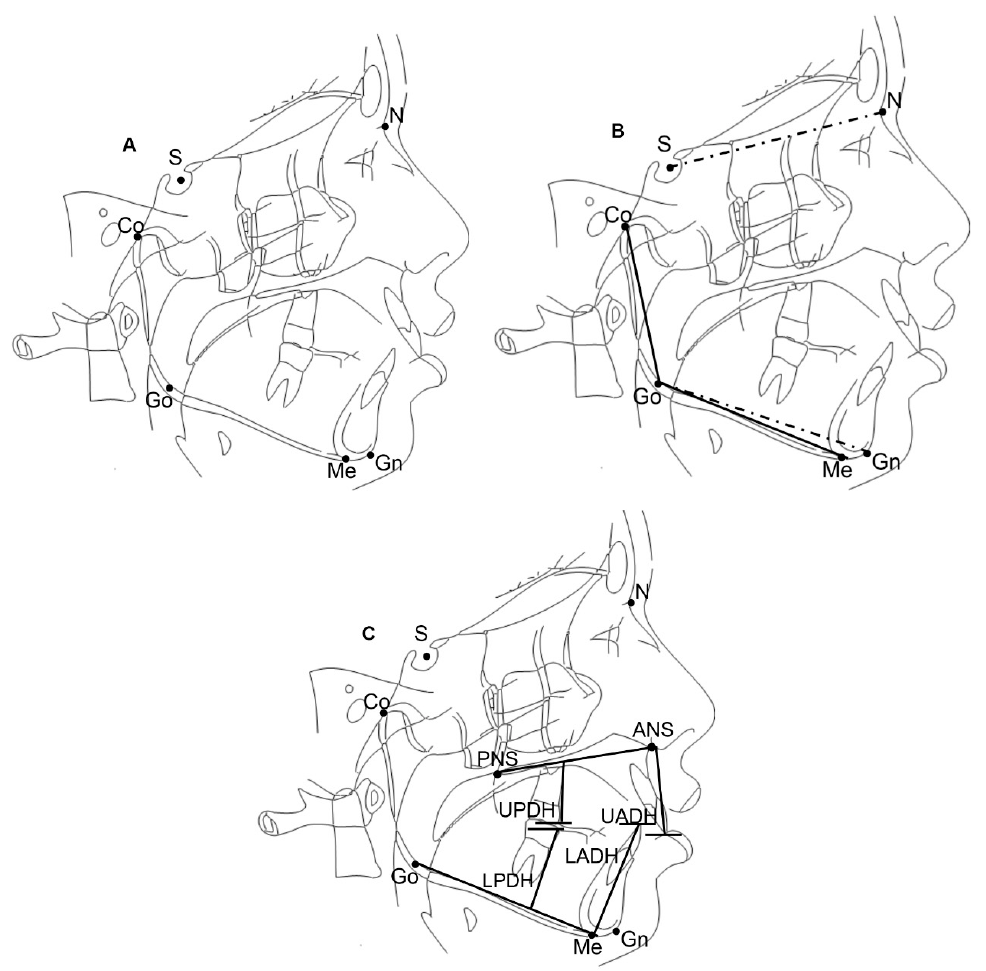
Figure 1. Skeletal landmarks, lines, and measurements used for cephalometric analysis. ( A ) Landmarks and lines : Sellion (S), the midpoint of the cavity of sella turcica; Nasion (N), the anterior point of the intersection between the nasal and frontal bones; Menton (Me), the intersection point of the posterior symphysis contour and the inferior contour of the corpus; Gonion (Go), the point on the contour of the mandible determined by bisecting the angle formed by the mandibular and ramus plane; Gnation (Gn), the point of intersection between the contour of the chin and the line bisecting the inferior border of the mandible and the line passing through N and Pg; Condylion (Co), the most posterior and superior points on the mandibular condyle; Anterior Nasal Spine point (ANS), the most anterior point of the bony hard palate in the mid-sagittal plane; Posterior Nasal Spine point (PNS), the most posterior point of the bony hard palate in the mid-sagittal plane; ( B ) Plane and angular measurements : Palatal plane (PP), a line that connects ANS to PNS; Mandibular plane (MP), a line that connects Go to Me; Gonion Gnation plane (GoGn), a line that connects Go to Gn; Nasion Sellion plane (SN), a line that connects N to S; Condilion Gonion Plane (CoGo), a line that connects Co to Go. SN^GoGn, the angle between the SN plane and GoGn; CoGoMe^, the angle between the CoGo and GoMe. ( C ) Vertical measurements : Dentoalveolar heights were measured for maxillary and mandibular incisors and first molars as the upper anterior dental height (UADH) measured as the perpendicular distance from the maxillary incisor edge to the palatal plane (mm); lower anterior dental height (LADH) measured as the perpendicular distance from the mandibular central incisor edge to the mandibular plane (mm); upper posterior dental height (UPDH) measured as the perpendicular distance from the mesiobuccal cusp tip of the maxillary first molar to the palatal plane (mm); and lower posterior dental height (LPDH) measured as the perpendicular distance from the mesiobuccal cusp tip of the mandibular first molar to the mandibular plane (mm).